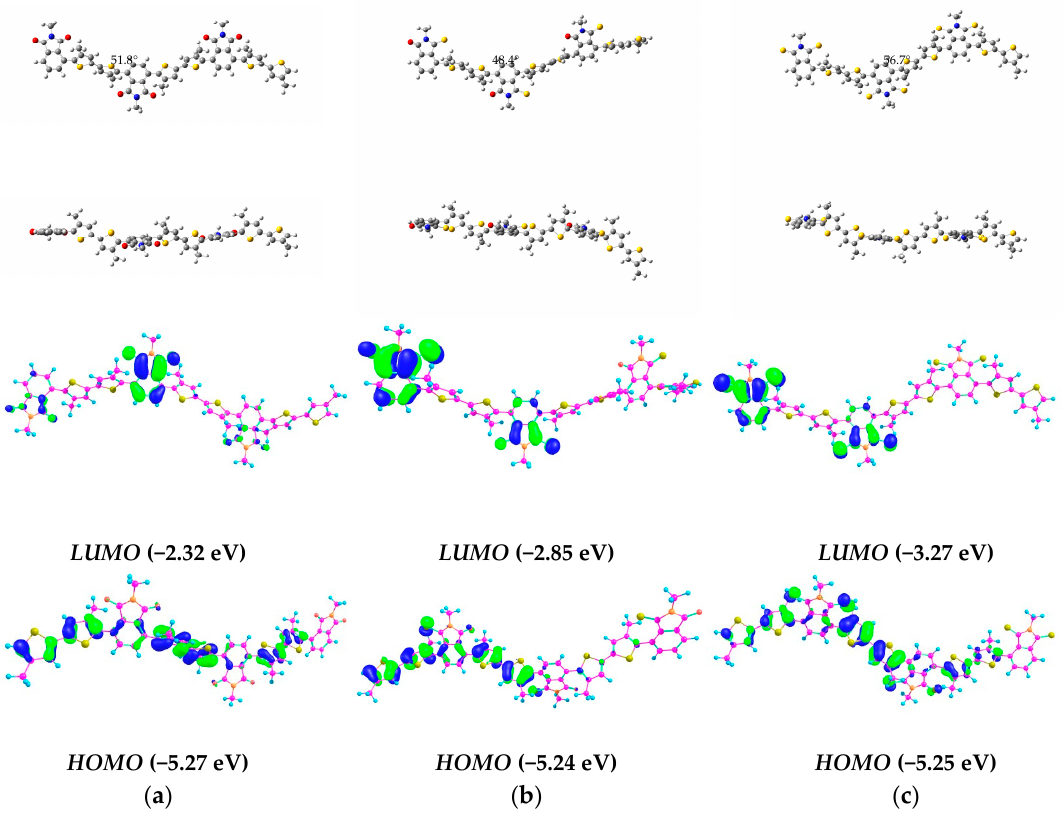
Figure 1. Optimized molecular geometry and the frontier orbital density distributions for P1 ( a ); P2 ( b ) and P3 ( c ) via DFT calculations (B3LYP/6-31G (d, p)). Dihedral angels between adjacent rings (degrees, °) were shown in black text (top structures). HOMO and LUMO molecular orbital diagrams were shown below with calculated energy levels.